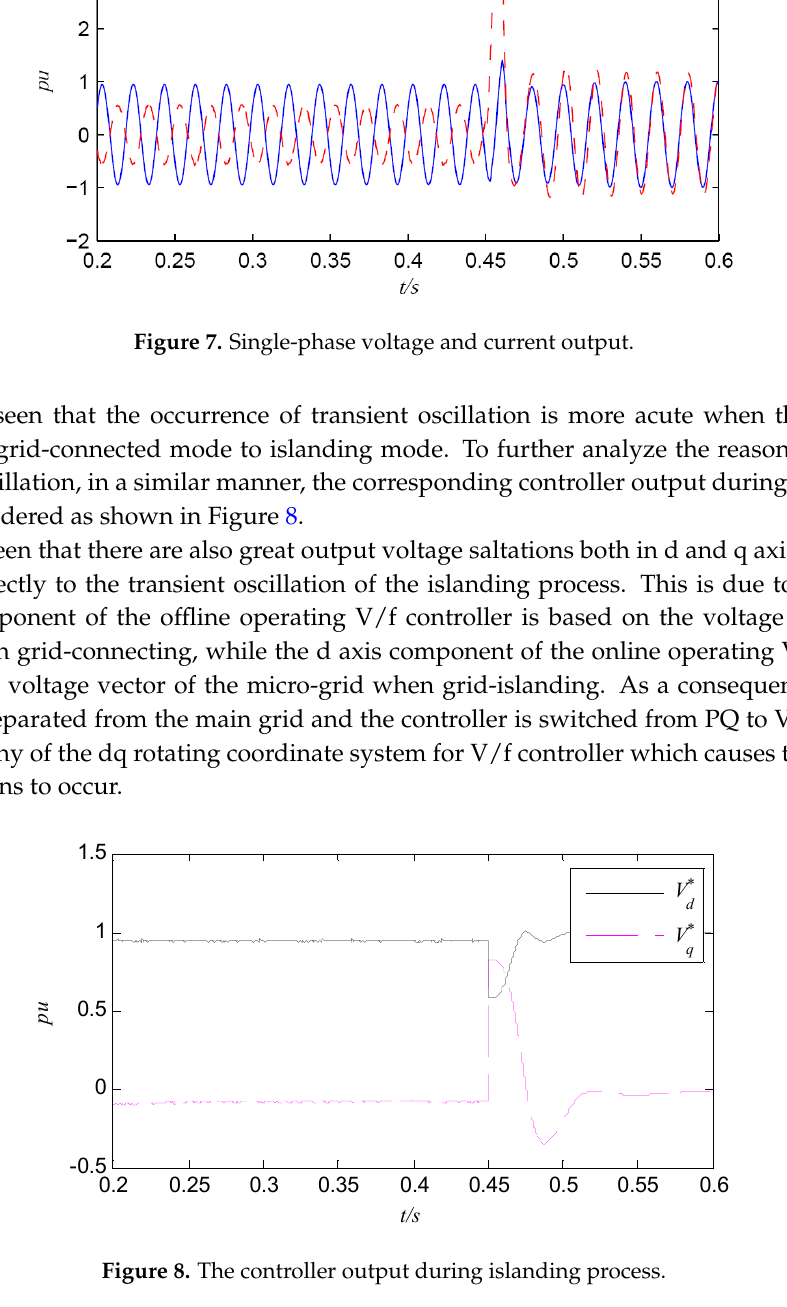
Figure 5. Single ‐ phase voltage and current output. Figure 6. The controller output during the grid ‐ connecting process. 3.2. Transient Oscillations in a Islanding Process The micro ‐ grid should be cut off in a timely manner from the main gird when some faults or unintentional switching events occur in the main power grid in order to maintain the local power supply. To continue with the case study above, this micro ‐ grid is initially considered to operate in